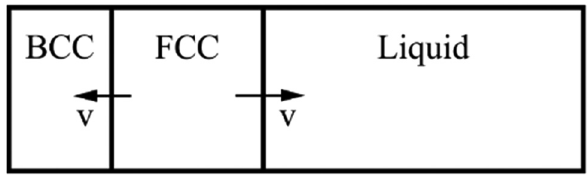
Figure 11: The schematic diagram of the geometry used in simulation process.